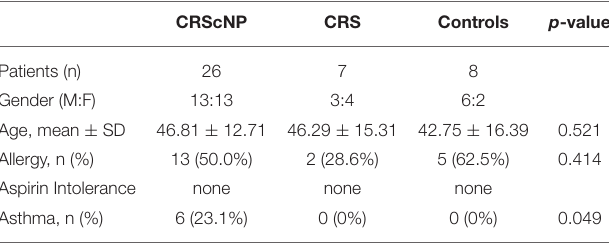
TABLE 1 | Demographic and clinical characteristics of patients ( N = 41).